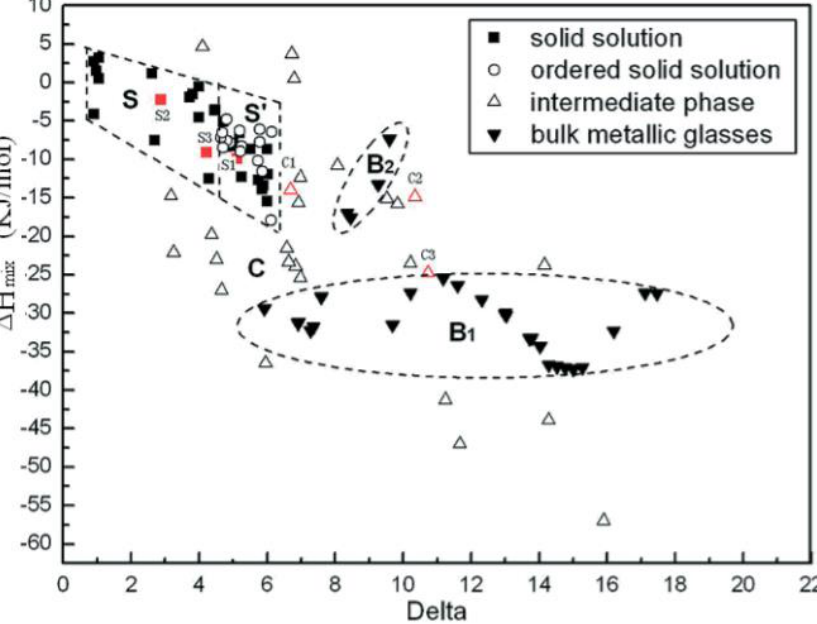
Figure 11. Relationship between atomic size difference (Delta) and mixing enthalpy ( Δ H mix ) for MHAs and typical multicomponent bulk metallic glasses [81]. (“solid solution” indicates the alloy contains only solid solution, “ordered solid solution” indicates minor ordered solid solution precipitate besides solid solution, and “intermediate phase” indicates there is precipitation of intermediate phases like intermetallics in HEAs. Red sign represents the alloys designed to verify the phase formation rules for multicomponent HEAs. Copyright 2008, Wiley.